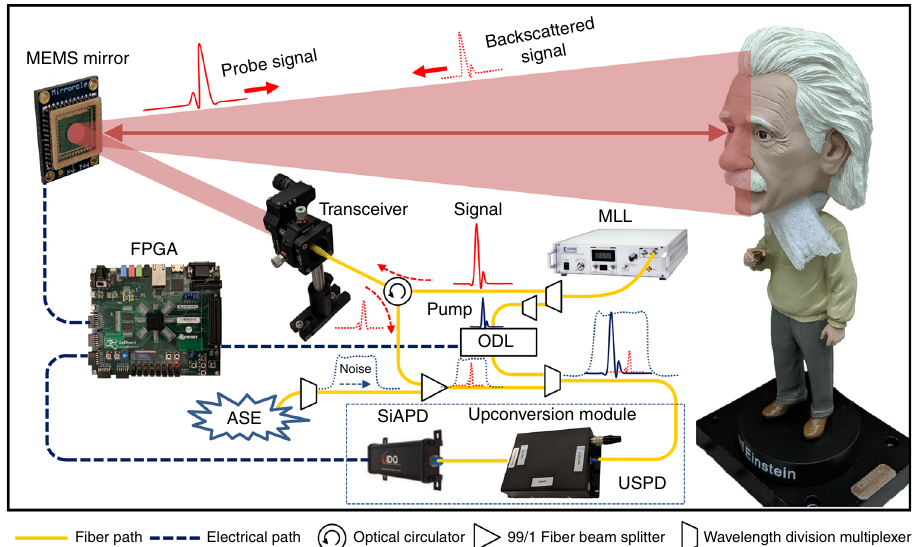
Fig. 1 Experimental setup of noise tolerant 3D single photon imaging. MLL, mode-locked fi ber laser (Repetition rate = 50 MHz, Center wavelength = 1560 nm); MEMS, micro-electro-mechanical systems; ODL, optical delay line; ASE, ampli fi ed spontaneous emission (1520 – 1570 nm); USPD, upconversion single photon detector; Si-APD, silicon avalanche photodiode; FPGA, fi eld-programmable-gate-array. Pump (1565.5nm) and probe (1554.1 nm) pulses are carved out from the MLL using off-the-shelf 200 GHz telecom wavelengths dense-wavelength-division-multiplexing (DWDM) fi lters. The FPGA is the central processor for controlling the programmable MEMS mirror and programmable ODL, and acquiring the data from the USPD. The noise, which is covering the identical spectral-temporal region as probe signal, is carved out from an ASE source with a DWDM fi Fig. 2a. Note that the time-resolving upconversion photon counting re fl ects the intensity-correlation of pump and back- scattered probe pulses, where the measured width is about 9 ps (versus ~500 ps for typical InGaAs APDs). This shows the ultrahigh timing resolution of our system upon a single-detection event, which is de fi ned by the phase matching of the upconver- sion and the full-width-half-maximum (FWHM) of optical pulses. It represents almost one order of magnitude improvement over the resolution achievable with Si-APDs whose timing jitter is typically capped at 50 ps. Sub-picosecond timing resolution is achievable with shorter optical pulses that can be created using spectrally wider fi lters and waveguides with broader phase matching 33 .